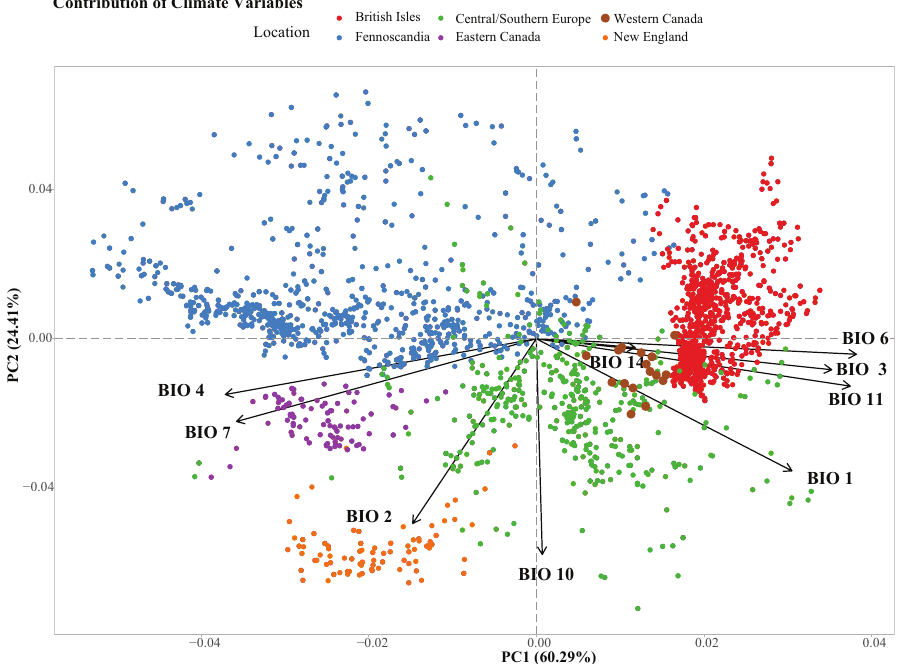
Figure 5. Plot of occurrences in each geographic region based on their values for the first two principal com- ponent axes derived from values of the nine environmental variables used in the MaxEnt models (Table